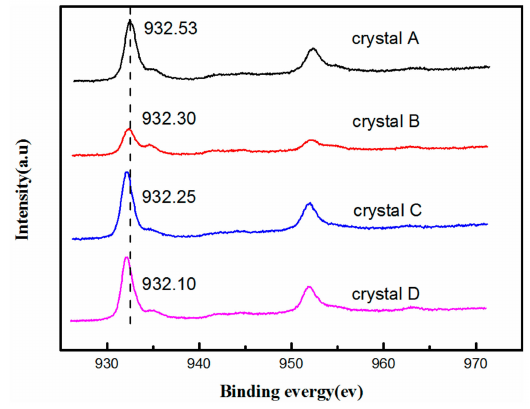
Figure 7. XPS spectra of the crystal A, crystal B, crystal C and crystal D for Cu 2p.